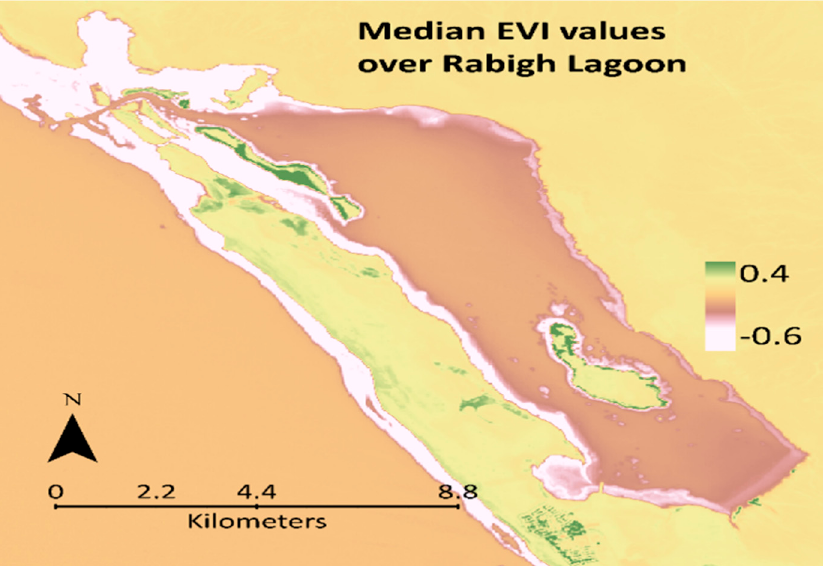
Figure 2. Median EVI over Rabigh Lagoon derived by calculating the median value using all the images between 1986 and